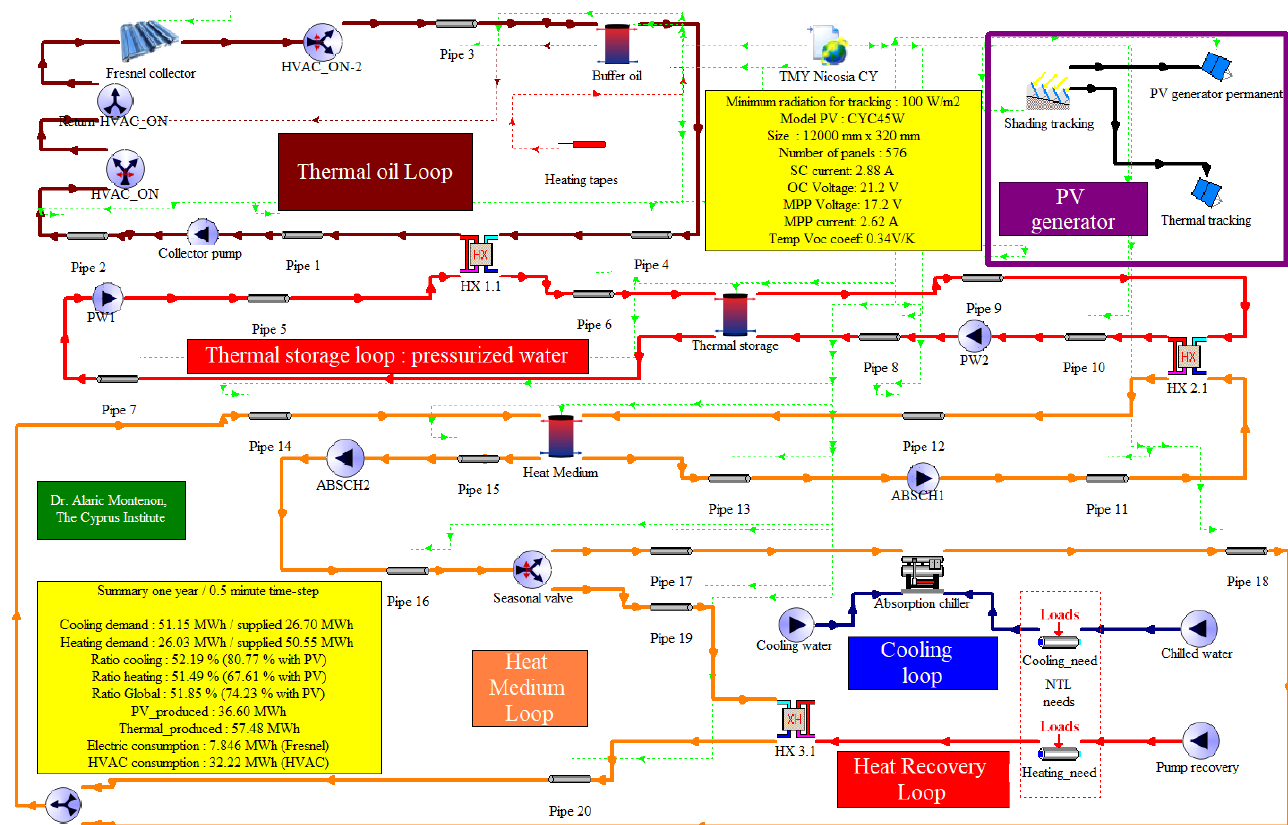
Figure 9. Simulation Studio template, with hidden control and output